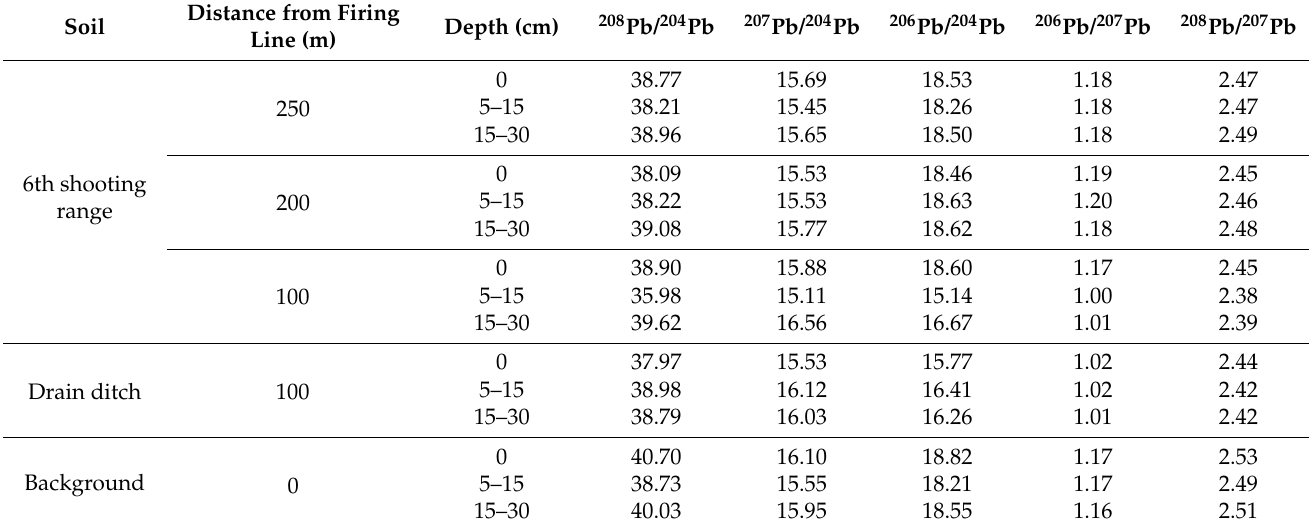
Table 2. The Pb isotope ratio of soils of 6th shooting lane with drain ditch and background. Distance from Soil